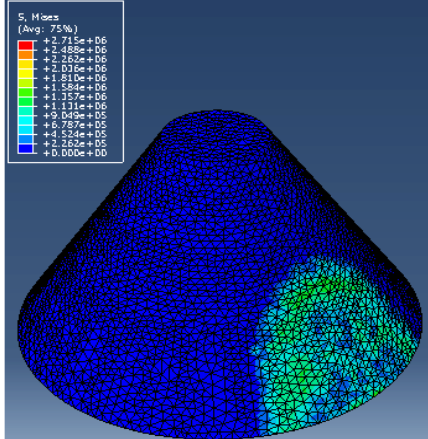
Fig. 8. Von misses composite stress contour in the frustum building in a moment after explosion strikes building in 6 meters high from ground